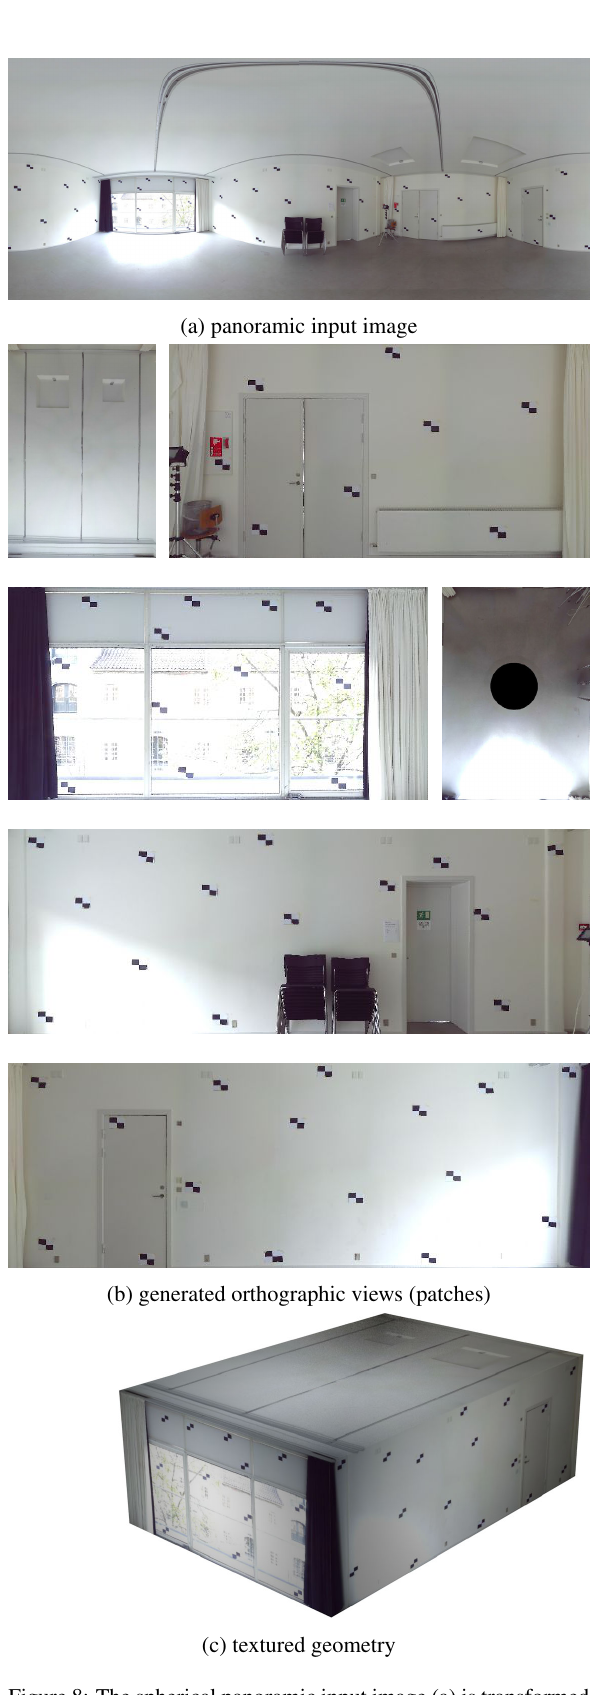
Figure 8: The spherical panoramic input image (a) is transformed into orthographic views (b) for each quadrilateral patch that was automatically identified from the input geometry. (c) shows a rendering of the textured